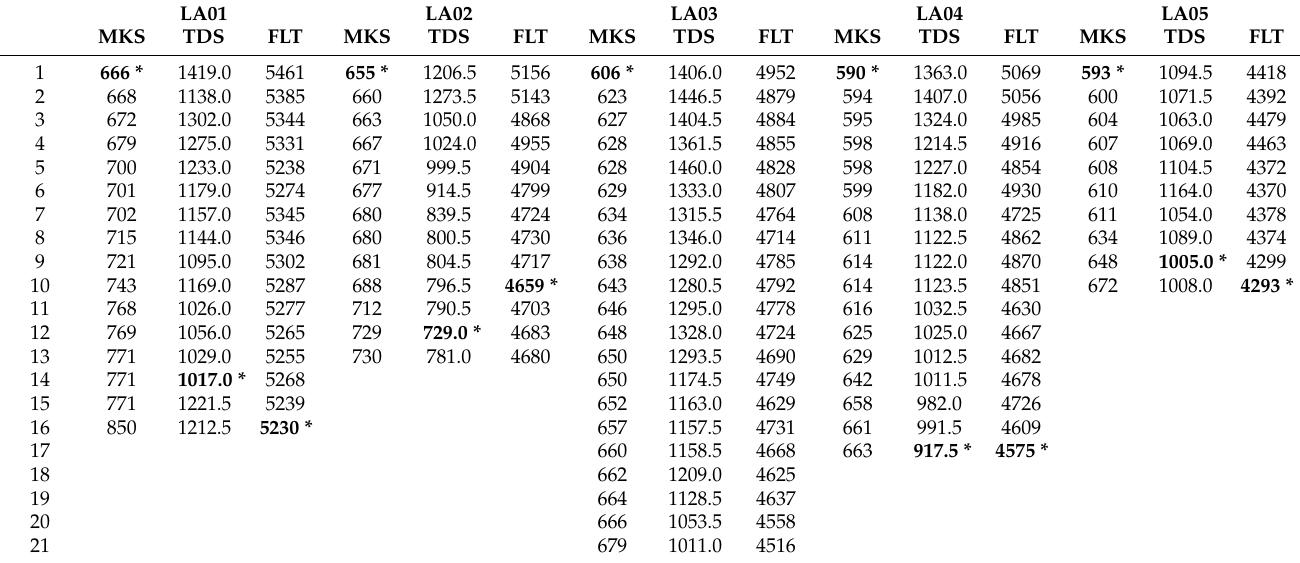
Table A9. Non-dominated solutions obtained by SS/CMOSA for the JSSP instances proposed by